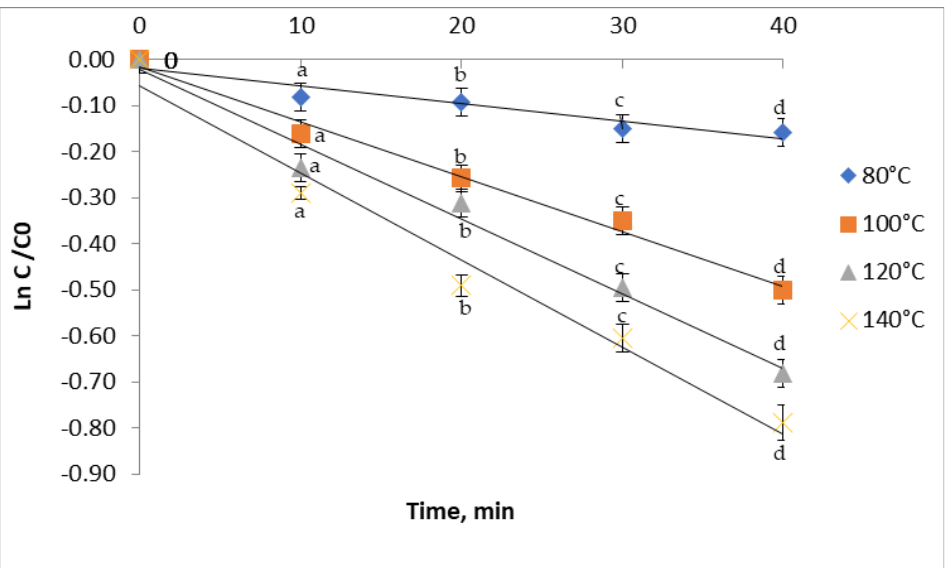
Figure 4. Isothermal degradation of TPC in red grape skin extract treated at different temperatures.